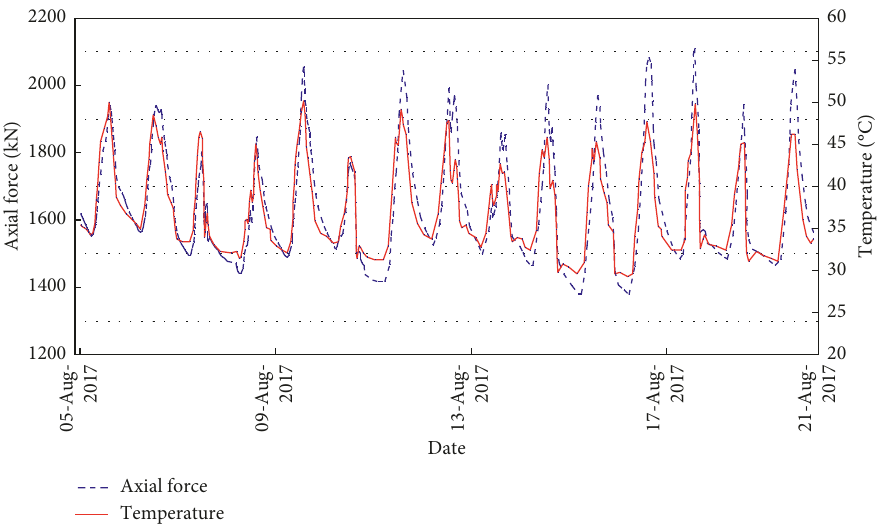
Figure 17: Changes in the trend of the axial force and temperature of the hydraulic servo steel Table 3: Statistics of the axial force of hydraulic servo strut.